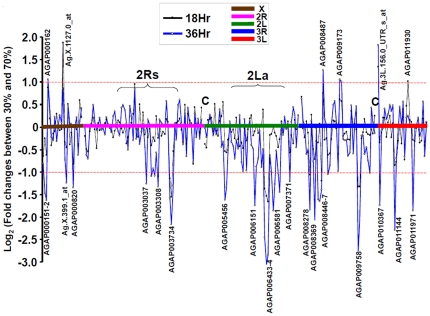
Changes in transcriptional profiles on alogarithm scale between
Anopheles gambiae
 mosquitoes exposed to 30% relative humidity in comparison to 70% relative humidity at 18 and 36 hours. The transcripts are arranged according to their chromosomal locations (X, 2R, 2L, 3R, and 3L). “C” represents the centromere. The transcript identity was labeled for those genes exhibiting more than a 2-fold difference in mRNA production (dashed lines).